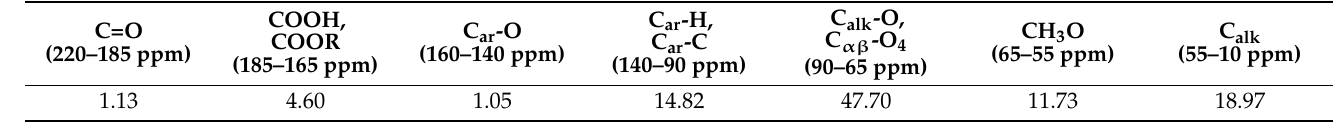
Table 1. Fragment compositions of studied FA. Content of C atoms in the structural fragments (relative integrated areas,